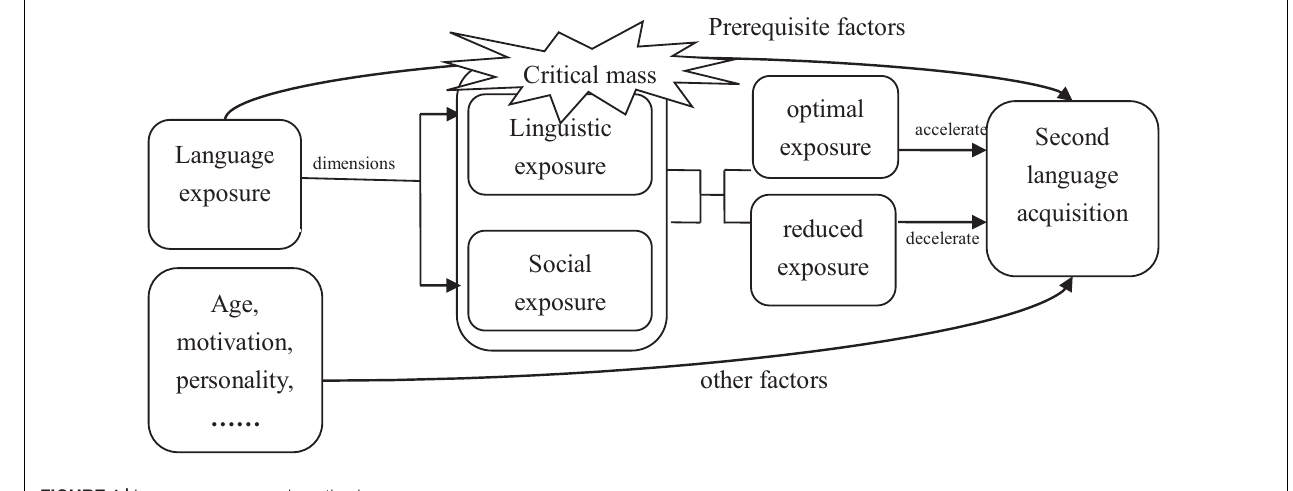
FIGURE 1 | Language exposure